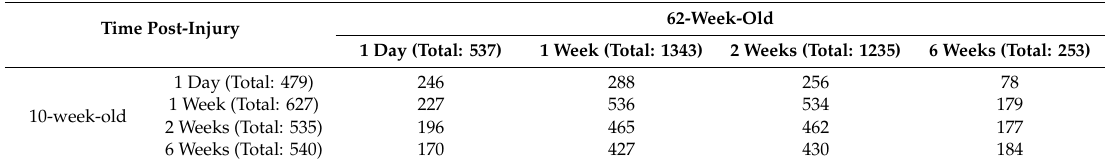
Table 1. Table showing up-regulated genes shared between 10-week-old and 62-week-old mice at various post-injury timepoints.